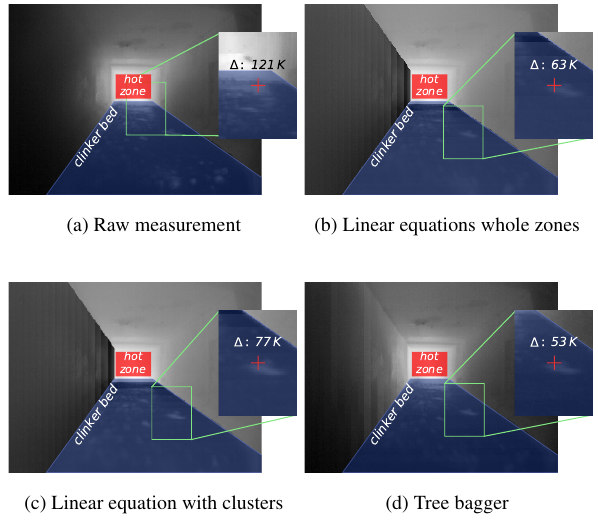
Figure 11. The maximum temperature difference from one frame to the other in a 1 minute